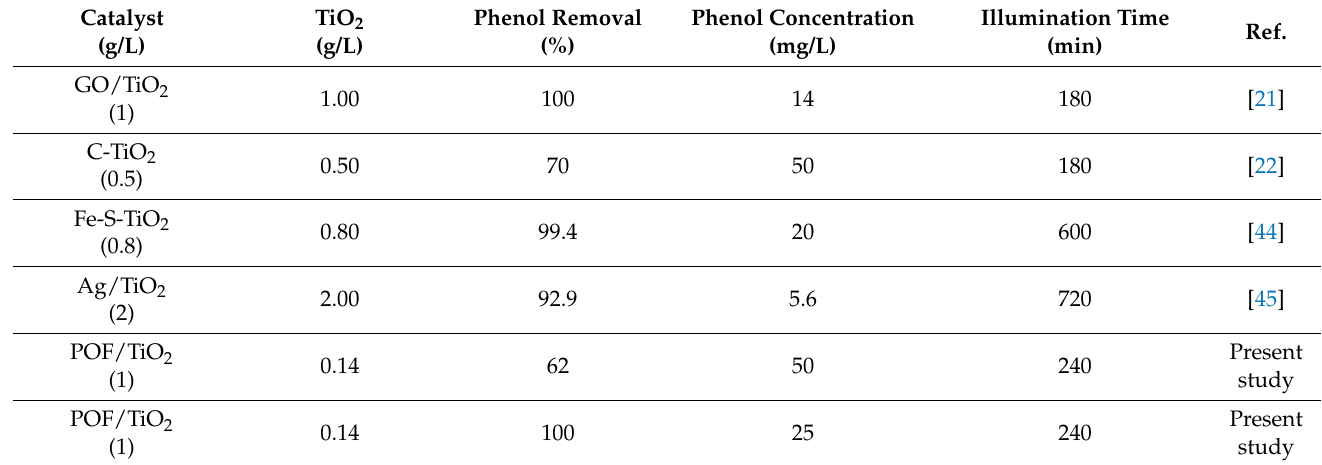
Table 3. Comparison of photocatalytic results for phenol